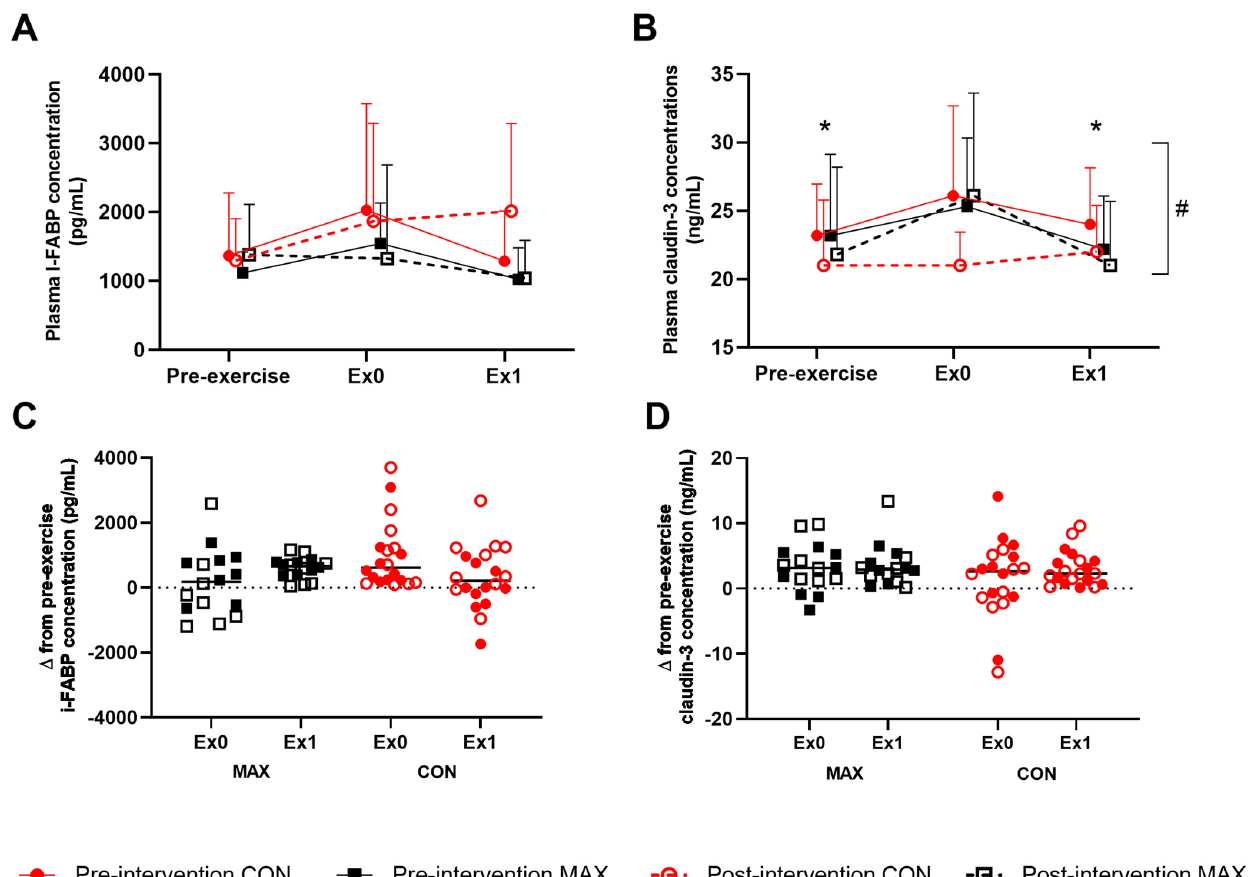
Figure 5. Mean ( A , B ) and individual changes ( C , D ) in plasma I-FAPB ( A , C ) and claudin-3 ( B , D ) concentration pre- and/or post-a 35-km race in highly-trained distance runners before (Pre-intervention) and after (Post-intervention) a protocol to increase endogenous and exogenous CHO availability (MAX), compared with a control condition (CON) involving moderate CHO availability. Data are mean and standard deviations; * = significant difference compared to Ex0. # = significant difference between pre- and post-intervention. Δ = change in reported variable.